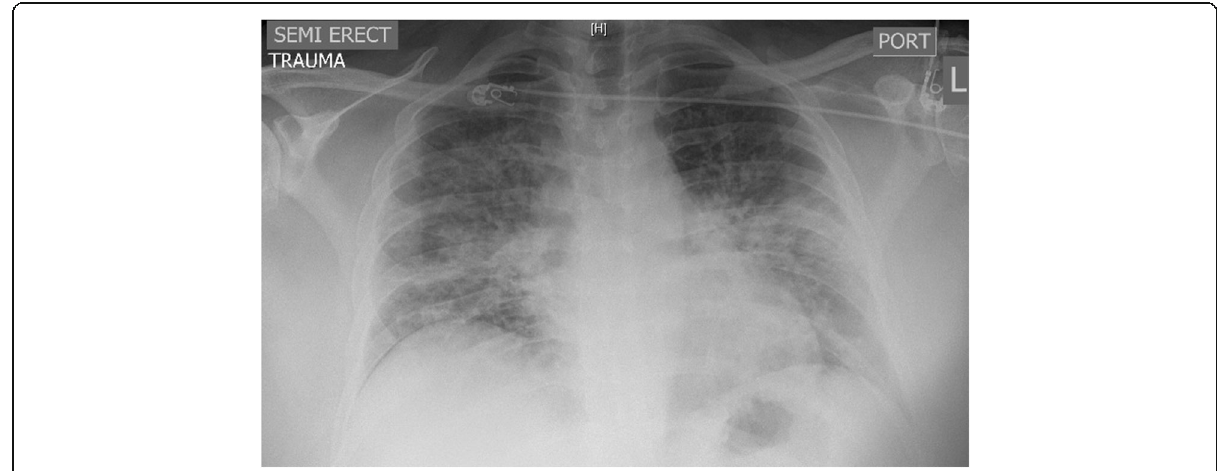
Fig. 1 Chest XRay of a patient with EVALI Showing bilateral patchy opacities